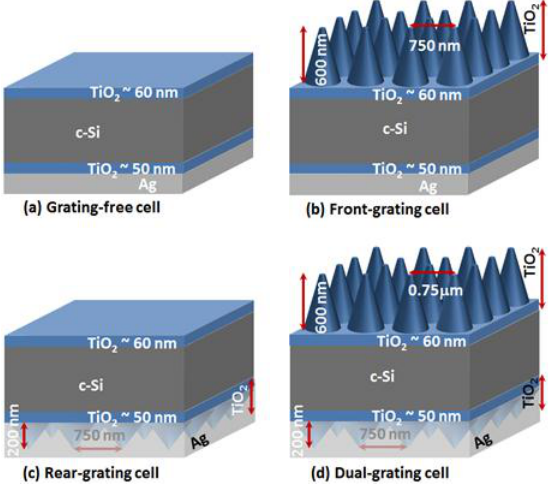
Figure 4. Sequence of light trapping structures on flat silicon. ( a ) Grating-free cell with thin layers of 60 and 50 nm on front and rear surface, respectively, and flat Ag back-reflector; ( b ) Front-grating cell with only front cones of height of 600 nm and a pitch of 750 nm and flat Ag back-reflector; ( c ) Rear-grating cell with only rear cones of height of 200 nm and a pitch of 750 nm and corrugated Ag back-reflector; ( d ) Dual-grating cell with a combination of front and rear cones with optimized parameters used in ‘b’ and ‘c’ with corrugated Ag back-reflector.